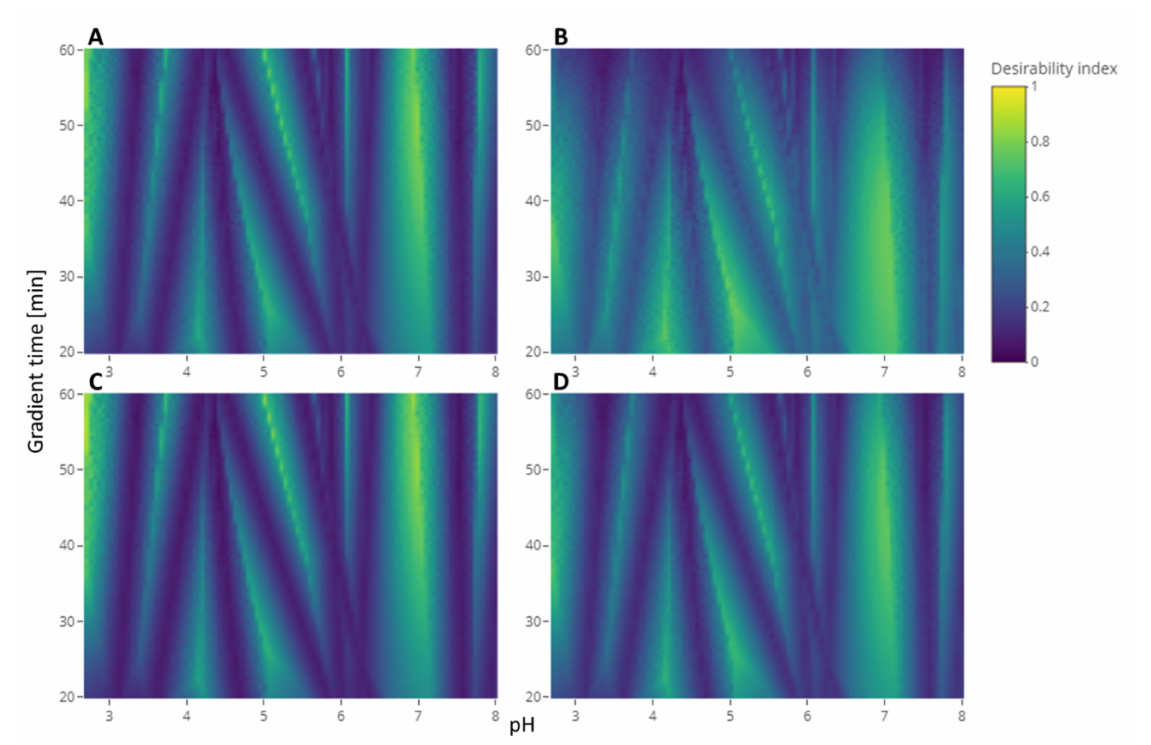
Figure 4. Heatmap of the desirability index in function of the pH and the gradient time calculated with different relative weights for the comparison of the effect of the weights on the desirability index. ( A ): the weights are 1 for the separation criterion, 0.5 for the sensitivity to experimental parameters criterion, and 0.1 for the analysis time criterion. ( B ): the weights are 1, 1 and 1. ( C ): the weights are 1, 0.4, and 0.05. ( D ): the weights are 1, 0.5, and